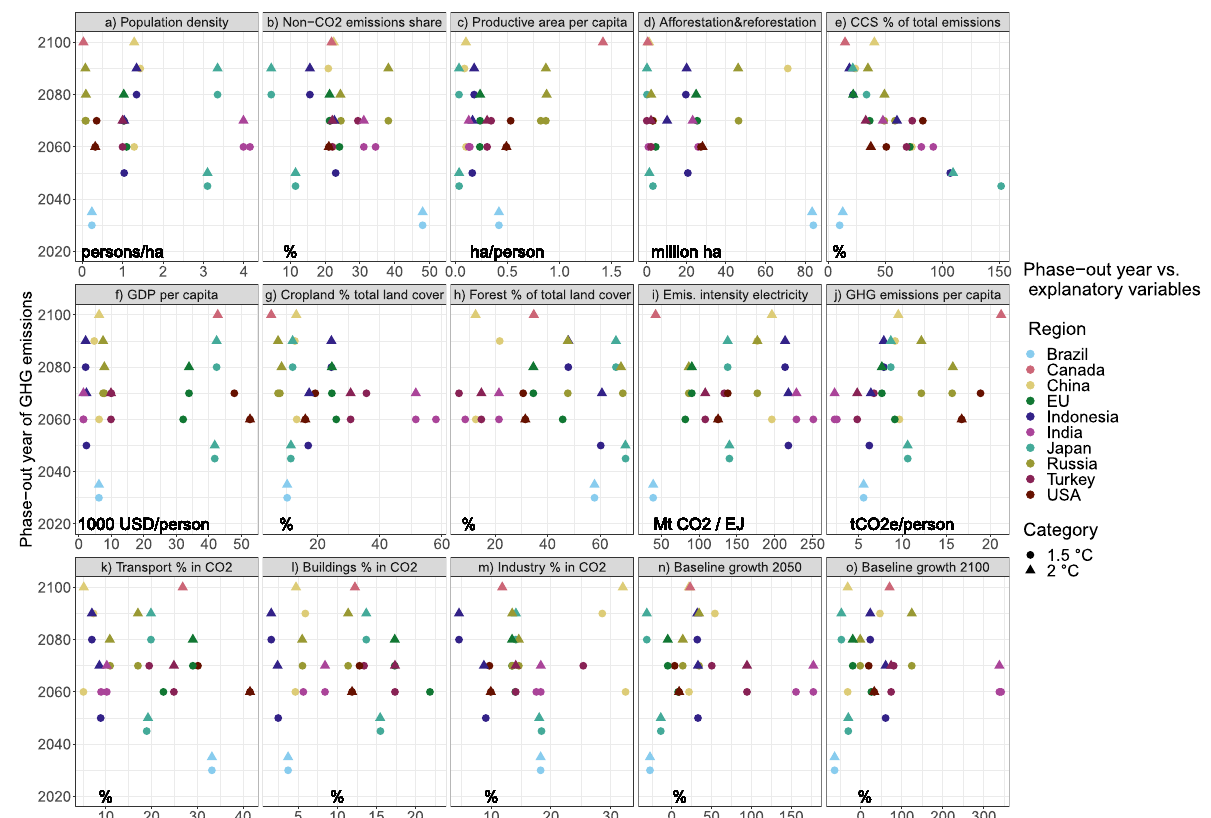
Fig. 3 Fifteen explanatory variables vs. phase-out years across the ten countries (colours), the POLES and IMAGE models, and the 1.5 °C and 2 °C scenarios (shapes). See Supplementary Table 2 for details of how the variables were calculated (units are displayed in the lower left corner of each